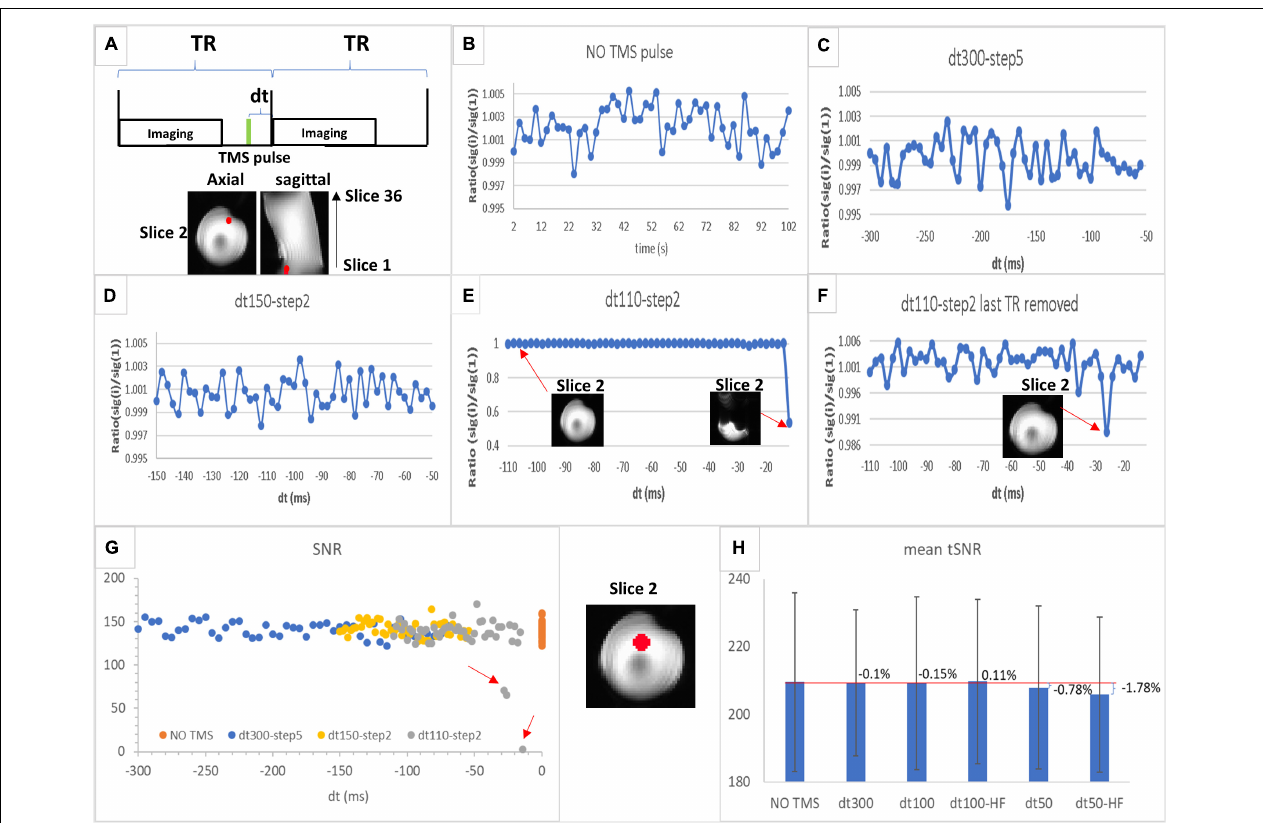
FIGURE 2 | (A) Schematic illustration of interleaved transcranial magnetic stimulation (TMS) and functional MRI (fMRI) data acquisition. dt is the time interval between TMS pulse (in green) and imaging acquisition block; TR is the repetition time. (B–F) Region of interest (ROI) values of MRI signal (ratio between value for each time point and the value for the first one) in a sphere (6 mm radius, in red) located at the slice 2 (the first slice acquired in an even number of slices acquisition mode) for experiments 1–4 as follows: (B) echo-planar imaging (EPI) acquisition without TMS pulse (experiment 1); (C) EPI acquisition with TMS applied at a rate of 1 pulse per volume with dt varying between 300 and 50 ms at a step of 5 ms (experiment 2); (D) EPI acquisition with TMS applied at a rate of 1 pulse per volume with dt varying between 150 and 50 ms at a step of 2 ms (experiment 3); (E) EPI acquisition with TMS applied in a rate of 1 pulse per volume with dt varying between 110 and 10 ms at a step of 2 ms (experiment 4) showing one image as an example of those unaffected by TMS and another from the last time point strongly affected by TMS pulse; (F) the same as (E) but without the last time point (dt = 10 ms). (G) Signal-to-noise ratio (SNR) values in the ROI (sphere of 12 mm radius highlighted in red displayed between G,H ) for each time point in the time series are plotted for each experiment shown in (B–E) [SNR values for NO TMS (B) are plotted at dt = 0]. The red arrows highlight those time points with SNR values lower than the normal range determined by the NO TMS run; (H) mean tSNR values in the same ROI as (G) for NO TMS (experiment 1), dt300 (experiment 5, single-pulse TMS followed by imaging with dt of 300 ms), dt100 (experiment 6, single-pulse TMS followed by imaging with dt of 100 ms), dt50 (experiment 7, single-pulse TMS followed by imaging with dt of 50 ms), dt100-HF [experiment 8, 5 pulses (10 Hz) TMS followed by imaging with dt of 100 ms; HF, high-frequency], and dt50-HF [experiment 9, 5 pulses (10 Hz) TMS followed by imaging with dt of 50 ms]. The bar graph displays the mean tSNR values in the ROI with the percent change as defined in Eq. 3 for each TMS experiment compared with the baseline (NO TMS), the error bar displays the SD of the tSNR values inside the